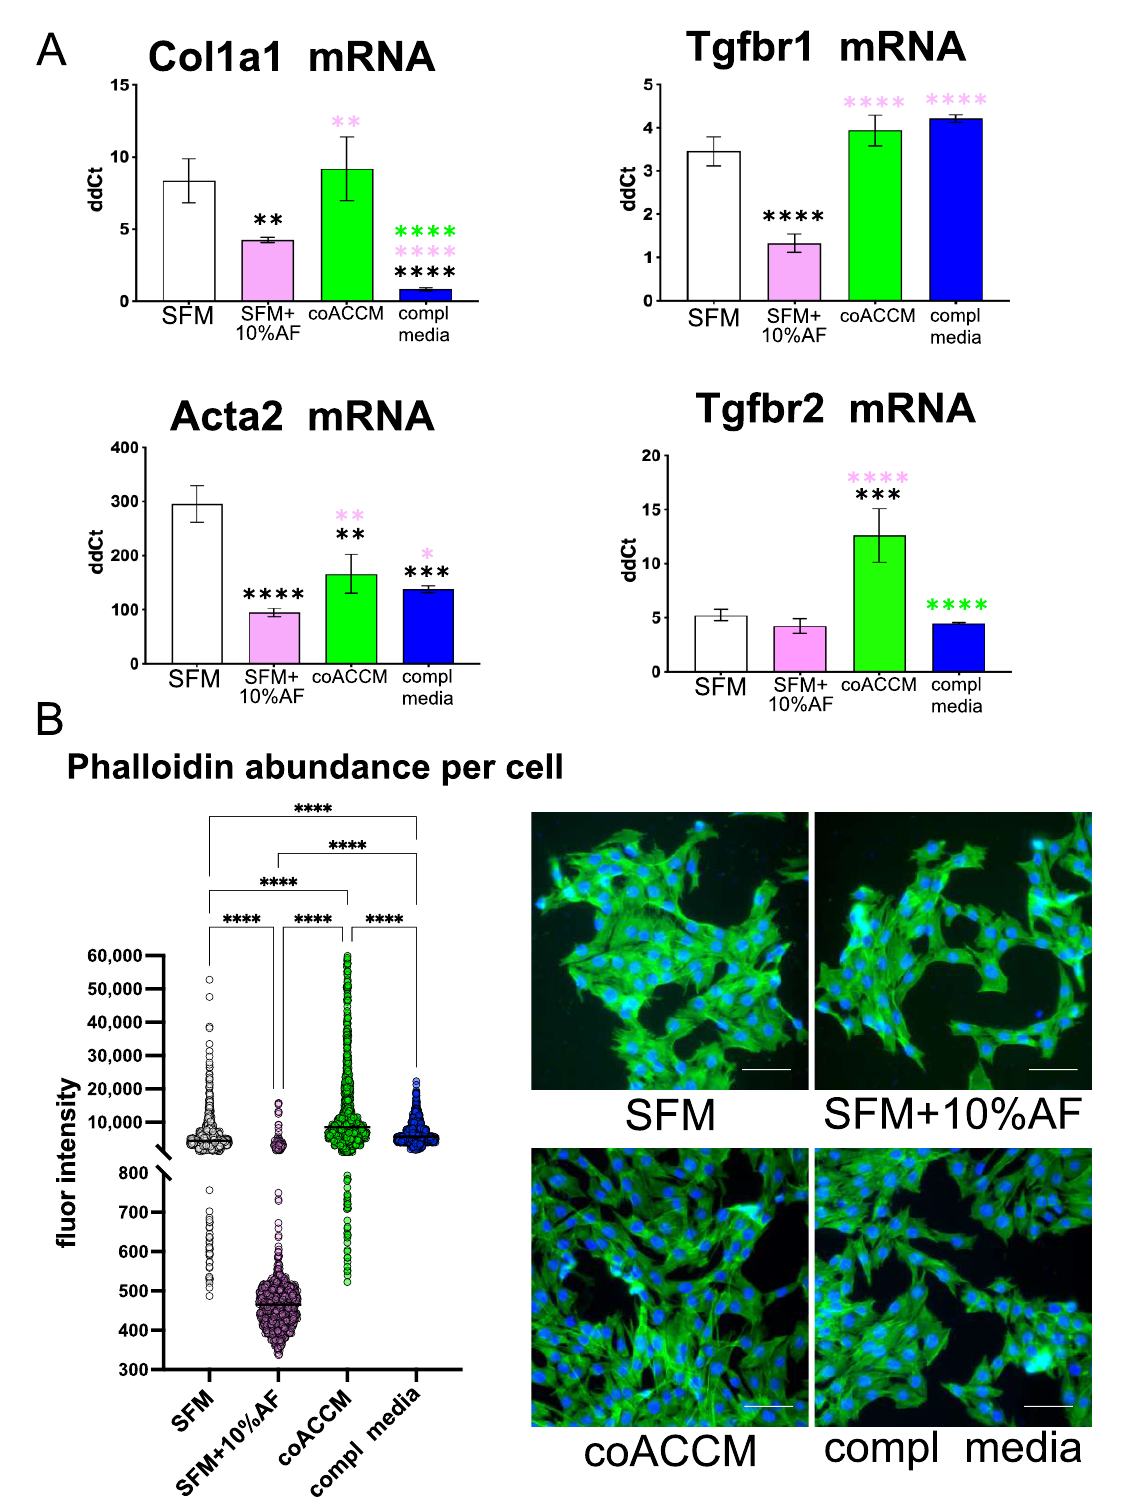
Figure 4. coACCM promotes MFA-associated gene expression in myoblasts, while AF reduces it. ( A ) RT-qPCR measuring Col1a1 , Tgfbr1 , Acta2 and Tgfbr2 mRNA extracted from C2C12 myoblasts cultured in biological triplicate in SFM, SFM + 10% AF, coACCM or complete media (compl media); * p < 0.05, ** p < 0.01, *** p < 0.001, and **** p < 0.0001 by one-way ANOVA and indicated by asterisks using the same color scheme described above. ( B ) High content screening analysis of phalloidin- stained (green) myoblasts’ fluorescence intensity per cell (left) with representative images shown on the right; scale bar = 100 µ m; **** p < 0.0001 by Mann–Whitney U